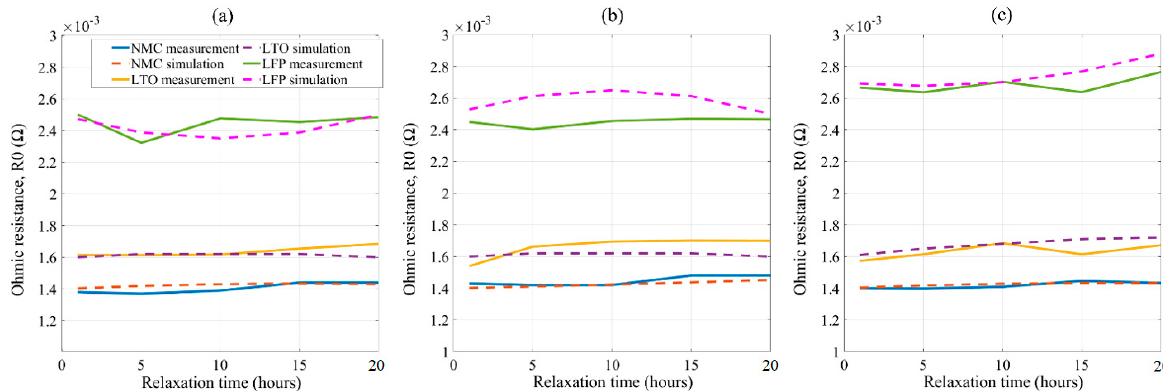
Figure 16. Validation results of ohmic contributions at ( a ) 80% SoC, ( b ) 50% SoC, and ( c ) 20%